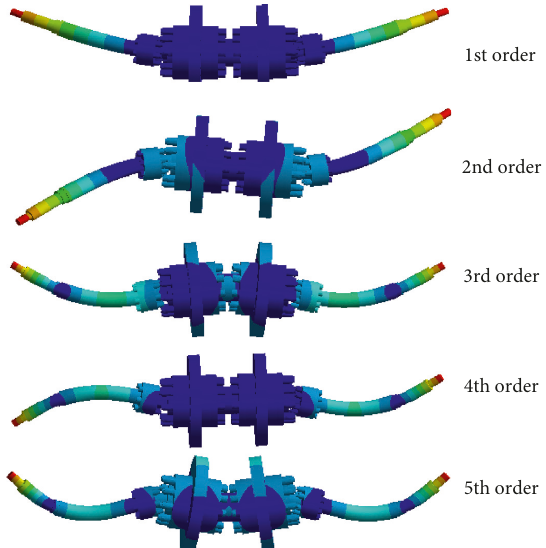
Figure 13: The first five flexural mode shapes of the experimental rod-fastened rotor.